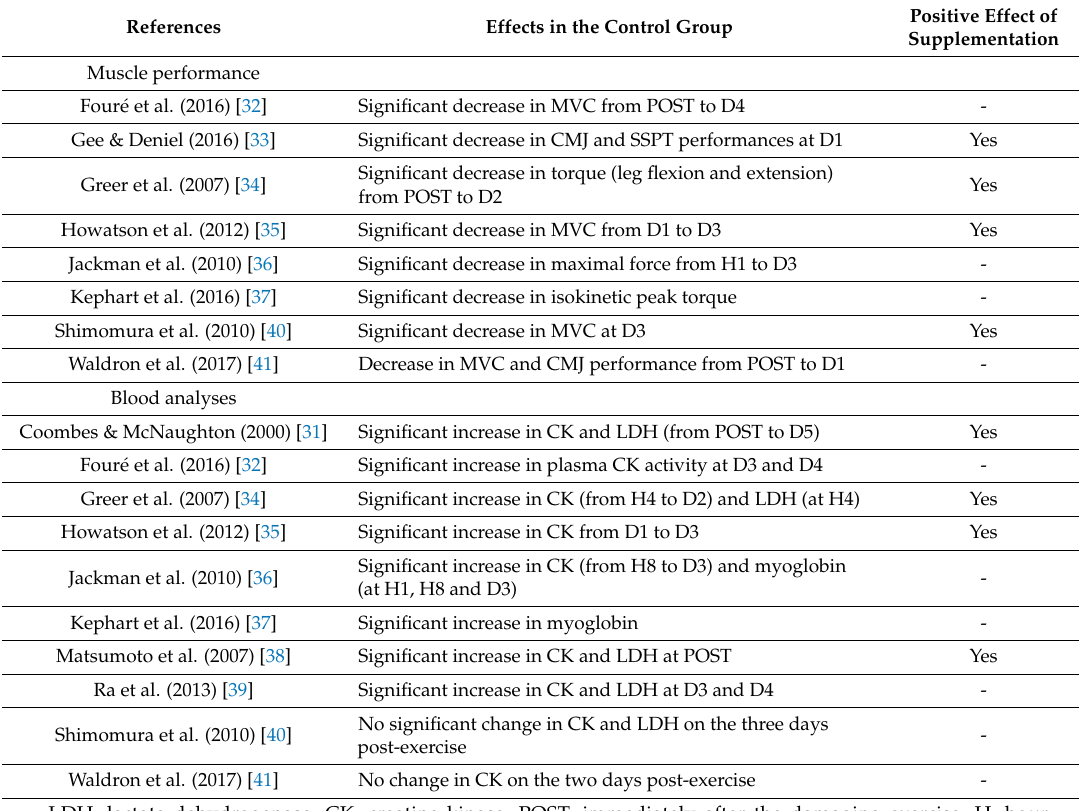
Table 5. Muscle damage exercise outcomes of included